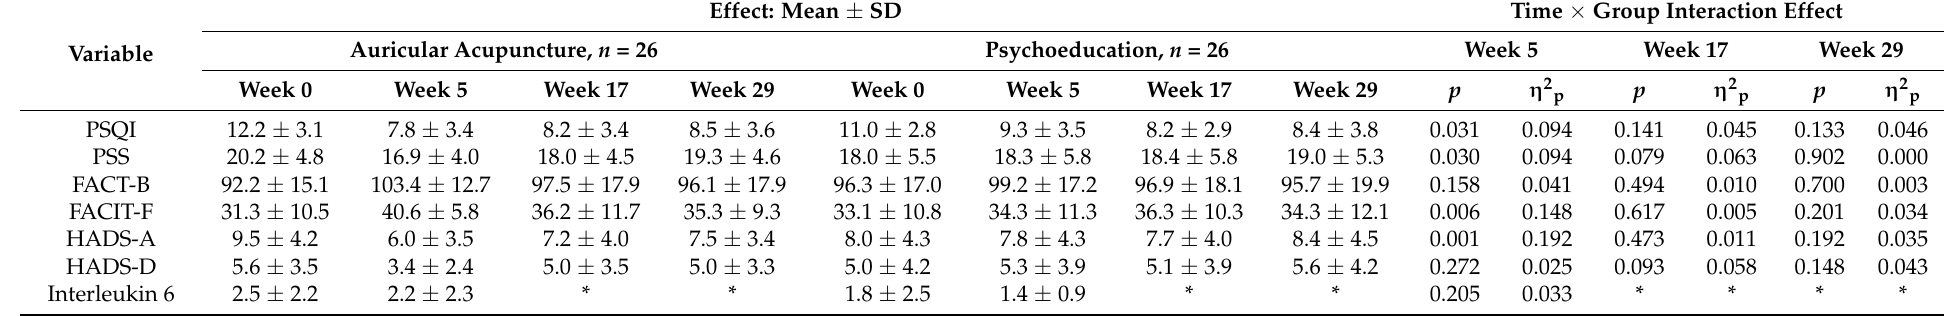
Table 3. Outcome